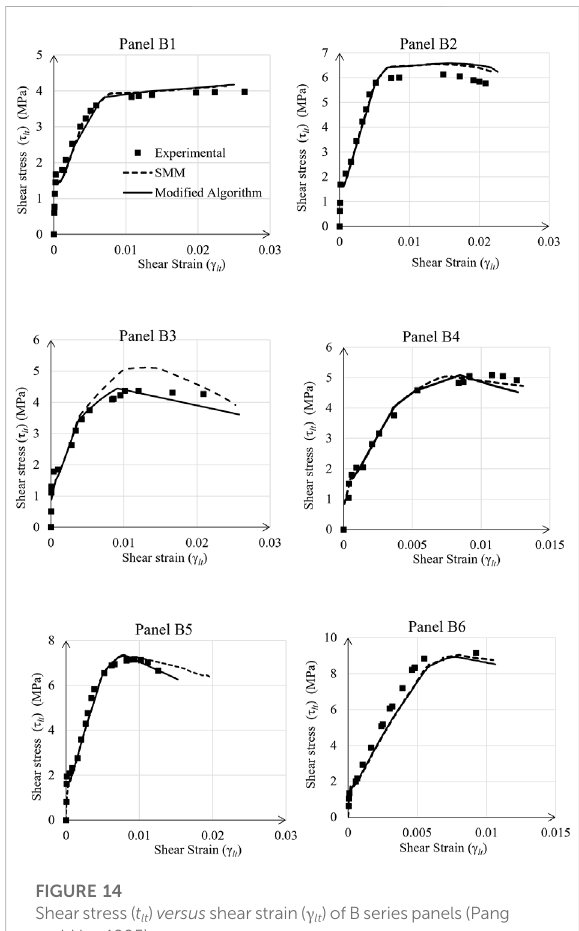
FIGURE 14 Shearstress( t lt ) versus shearstrain( γ lt )ofBseriespanels(Pang and